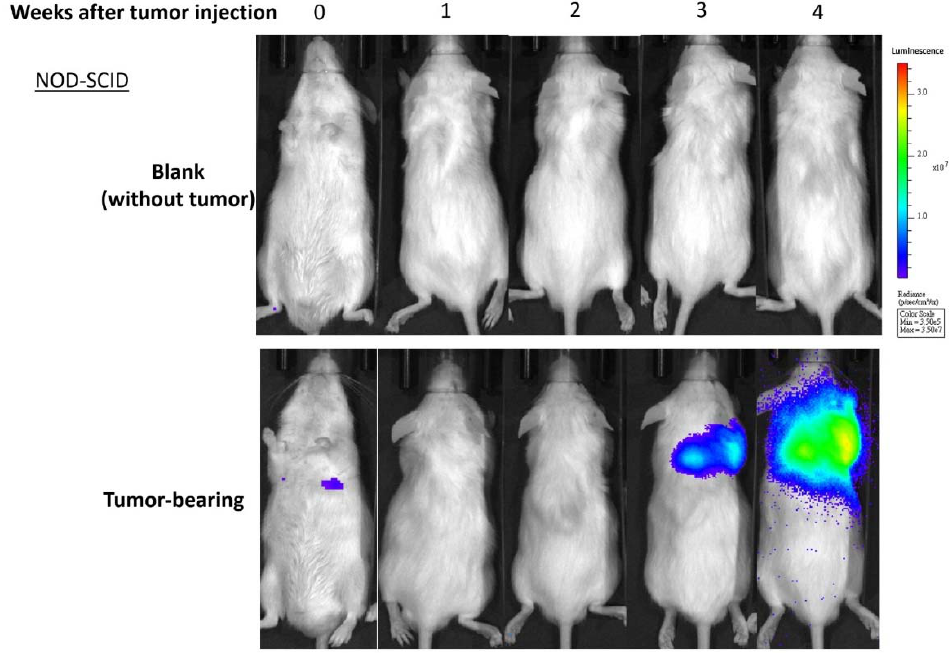
Figure 1. Tumor-specific bioluminescent images in representative mice. Groups of NOD-SCID mice (N = 5, age of eight weeks) were inoculated with 3 × 10 5 cells of metastatic human prostate cancer 22Rv1-M4 cells vs. mock control (PBS). Based on the housekeeping expression of the luciferase 2 (Luc2) reporter gene in the tumor cells, in vivo bioluminescent imaging of tumors was captured and quantified using an IVIS Lumina XRMS System weekly as